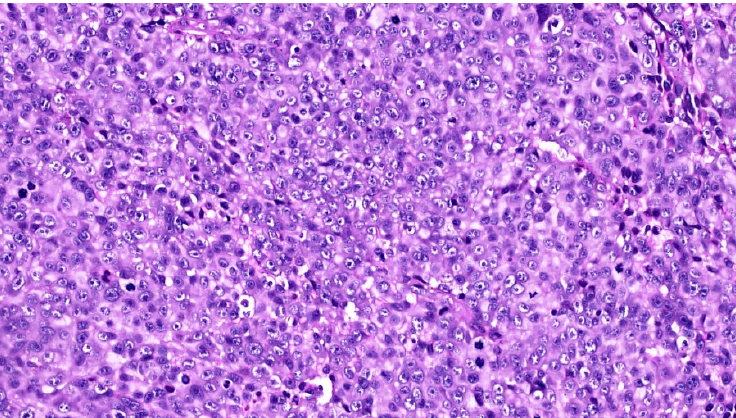
Figure 5. The tumor cells are epithelioid in shape, amelanotic and arranged in nests or nodules (Hematoxylin & Eosin, ×20).